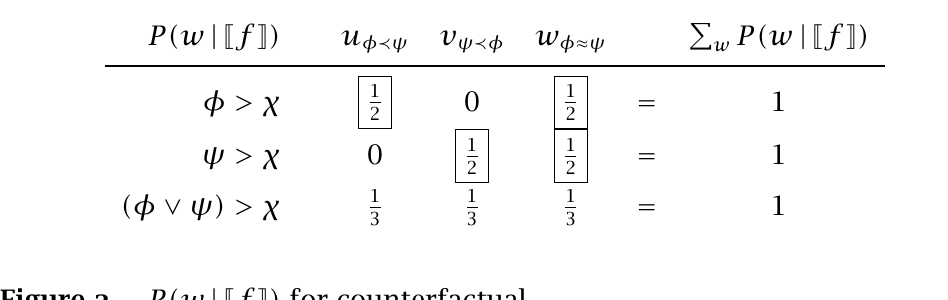
Figure 1 P(w | (cid:130)φ(cid:131)) for standard scale